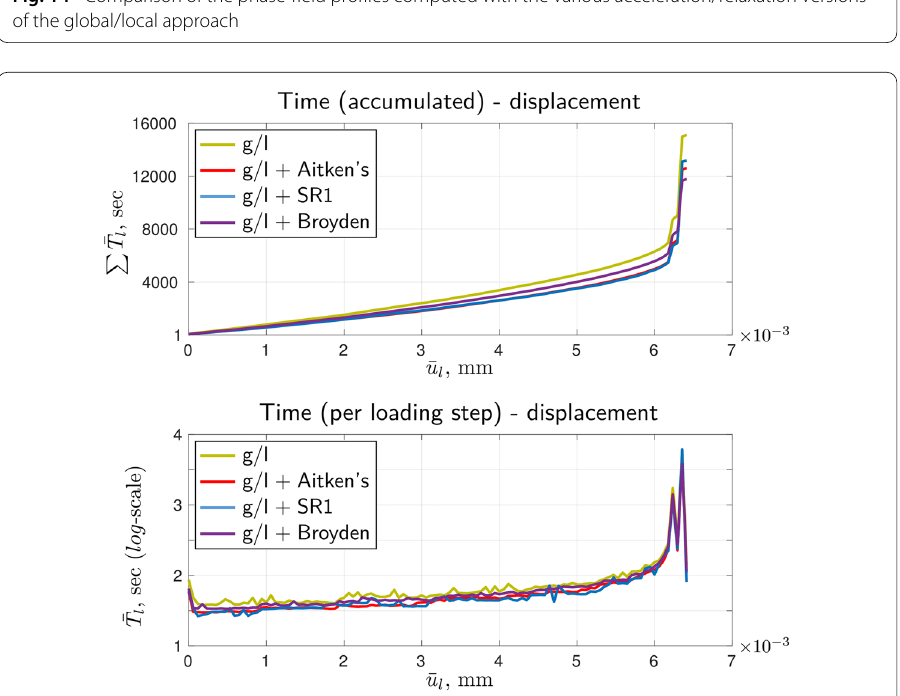
Fig. 15 Comparison of the time-displacement curves presented in different